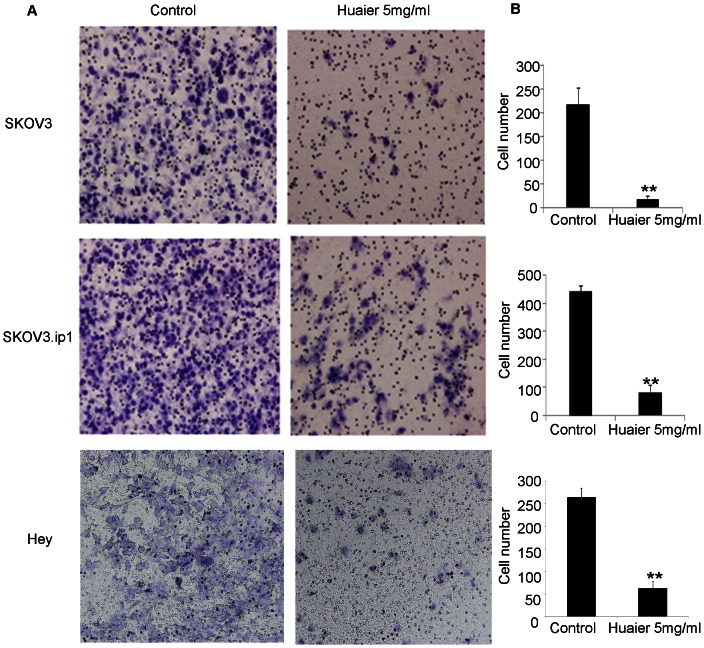
Huaier inhibits the invasion of ovarian cancer cells in vitro.(A) The effect of Huaier on the invasion of SKOV3, SKOV3.ip1 and Hey cells was examined using the Transwell system. Representative images are presented. (B) After a 24 hour treatment with 5 mg/ml Huaier, the number of successfully invading SKOV3, SKOV3.ip1 and Hey cells was counted. The data are presented as means ± SD. ** P<0.01 compared with the control.